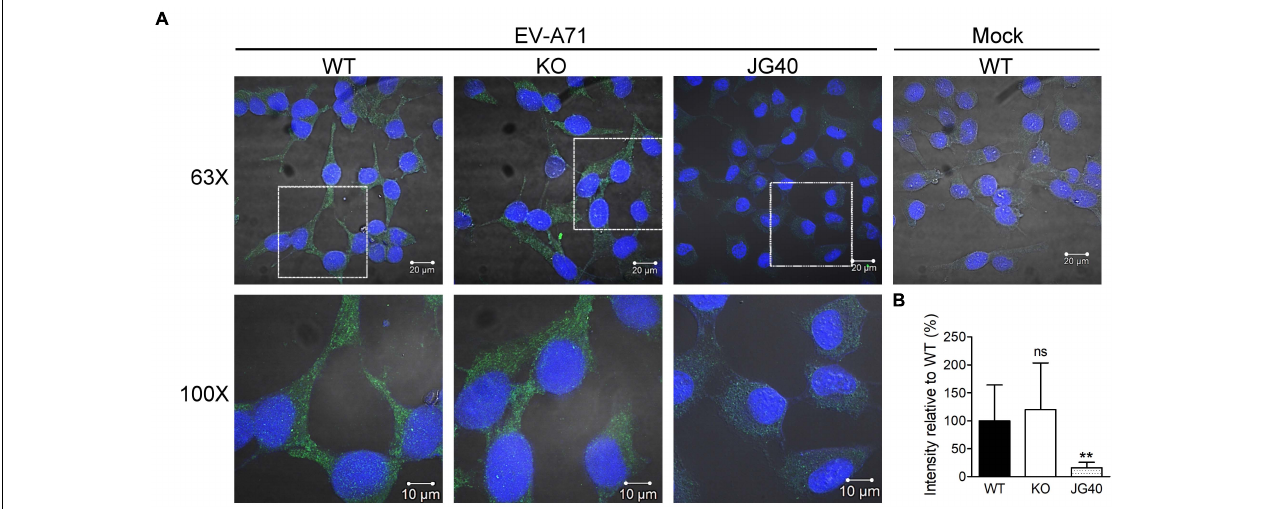
FIGURE 3 | HSPA6 is not needed for EV-A71 internalization. WT RD or HSPA6 KO RD cells, pretreated with cycloheximide (CHX, 100 µ g/ml) to prevent viral RNA translation, were infected with EV-A71 (MOI = 300). JG40 (5 µ M), an EV-A71 inhibitor, was used as a control. One hour later, the cells were fixed, permeabilized, and incubated with anti-VP0/VP2 primary antibody, followed by Alexa Fluor 488 labeled secondary antibody. (A) Cell images captured by confocal fluorescent microscopy at 63 × and 100 × were shown (green: VP0/VP1; blue: nuclei). (B) The integrated green fluorescence intensities, averaged from 10–15 fields (20–30 cells/field), were compared between signals from WT RD and HSPA6 KO RD cells. The results, presented as means ± SD of one set of images, are shown here. Similar results were obtained from at least two other sets of experiments. Unpaired Student’s t -test was performed to compare the differences between WT and HSPA6 KO cells. ns, not